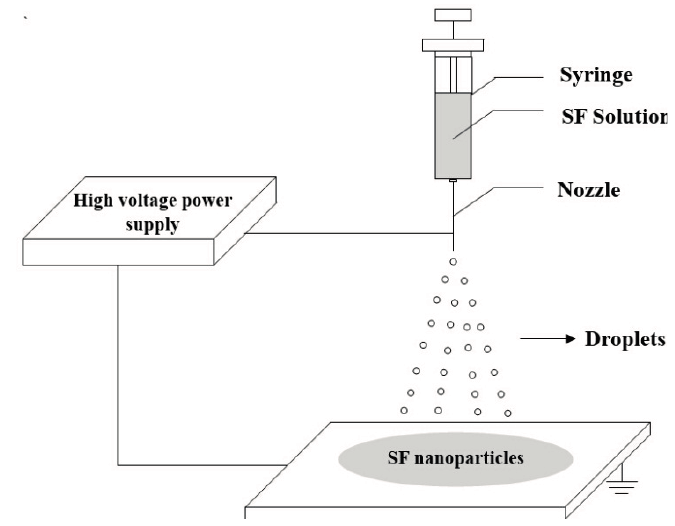
Figure 4. Schematic diagram of the electrospraying method for preparing SF nanoparticles.